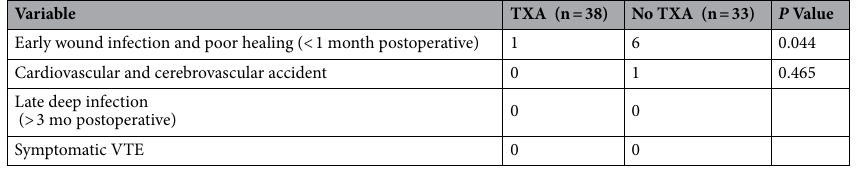
Table 4. Complications following